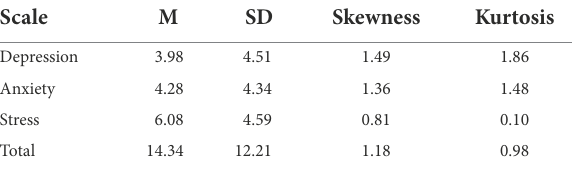
TABLE 1 Descriptive statistics for the